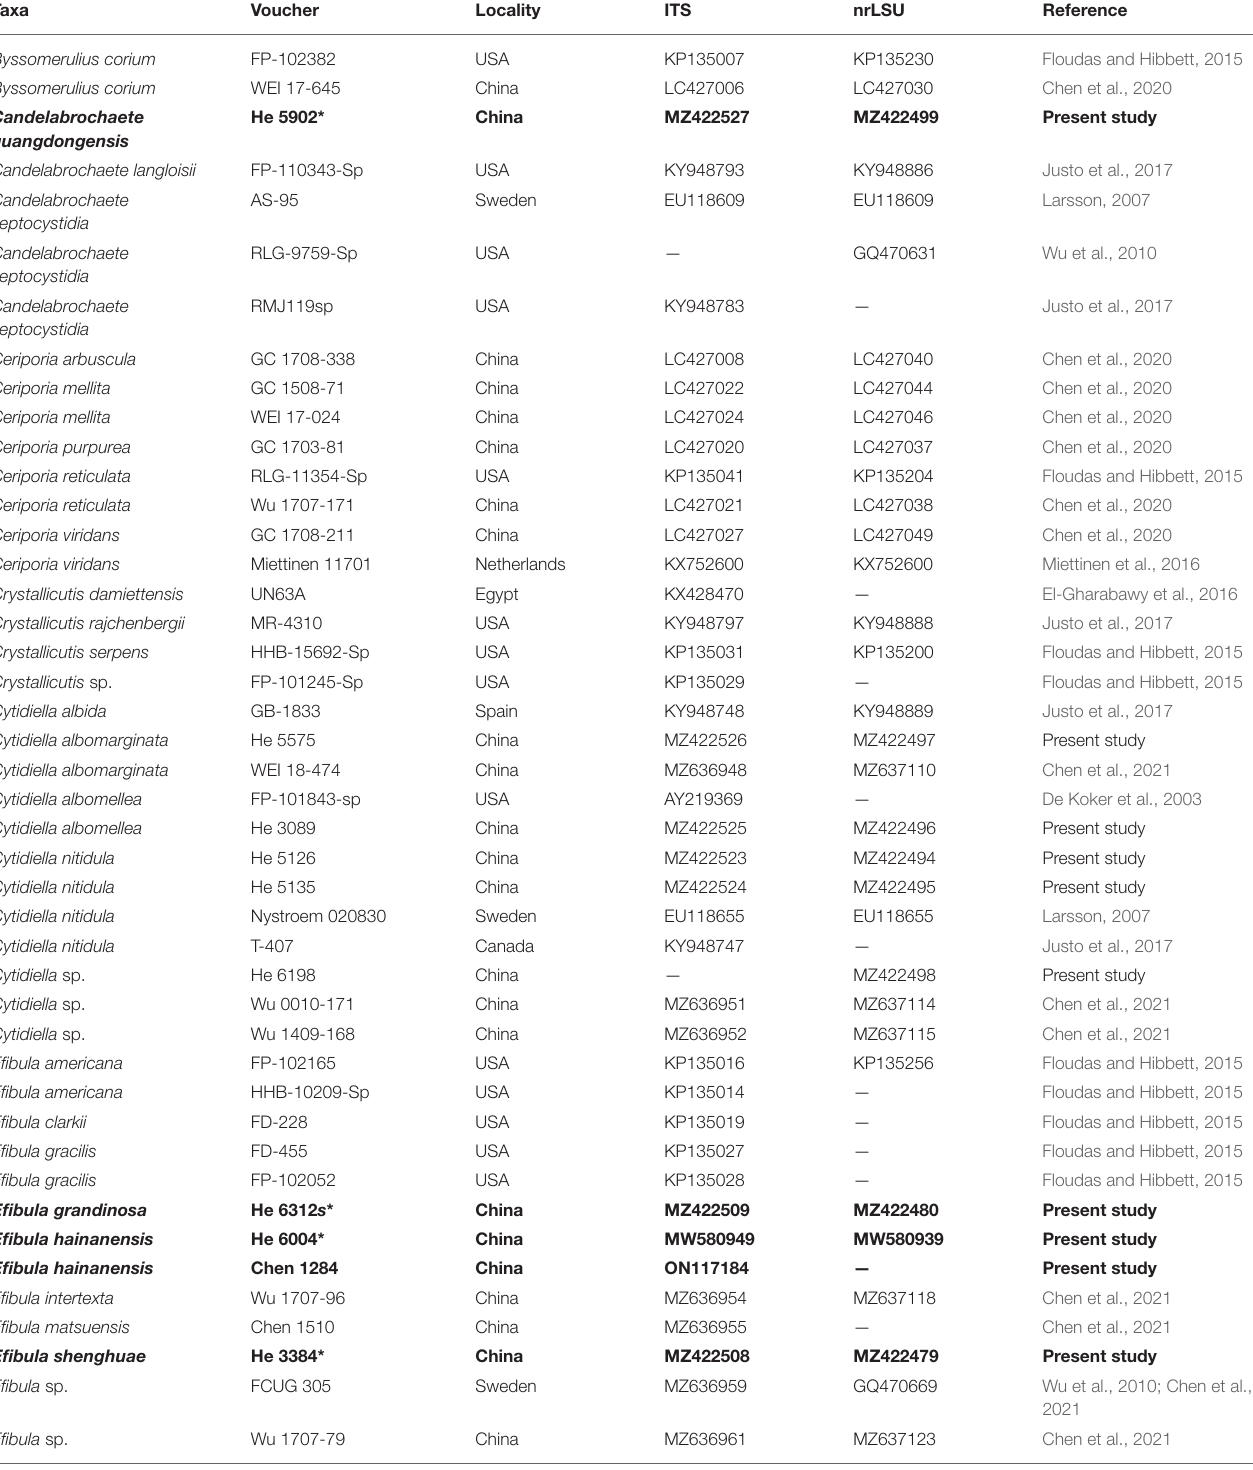
TABLE 1 | Species and sequences used in the phylogenetic